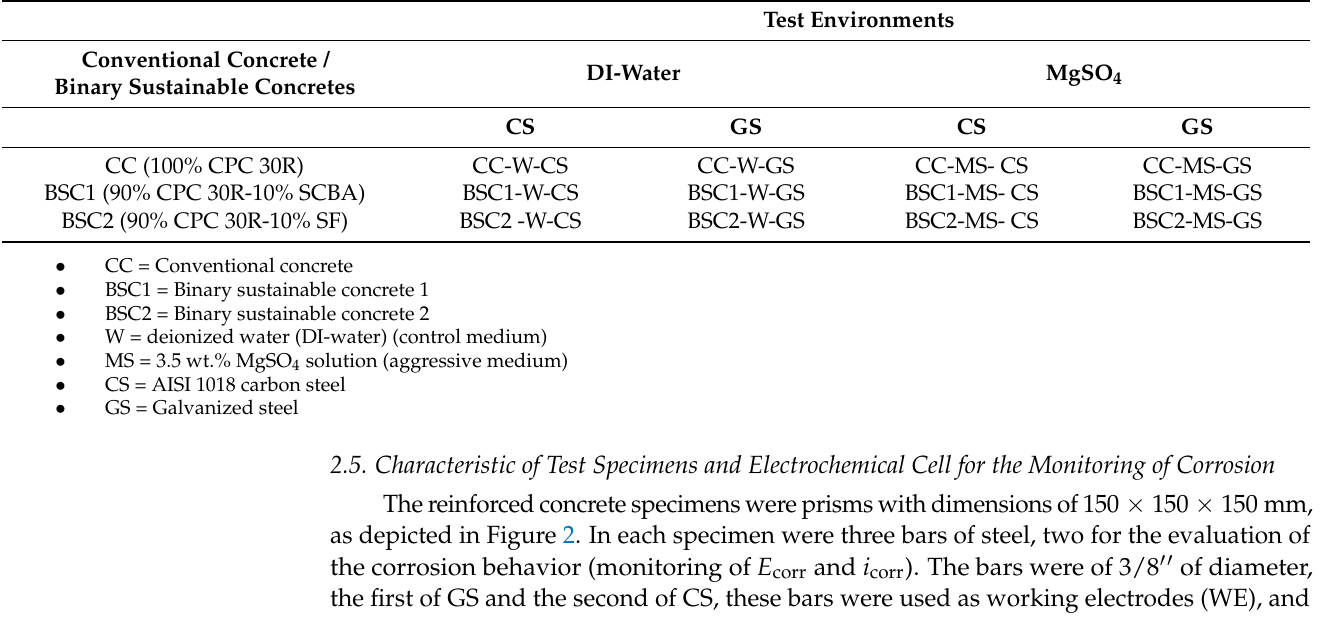
Table 5. Nomenclature of specimens for evaluation of corrosion.